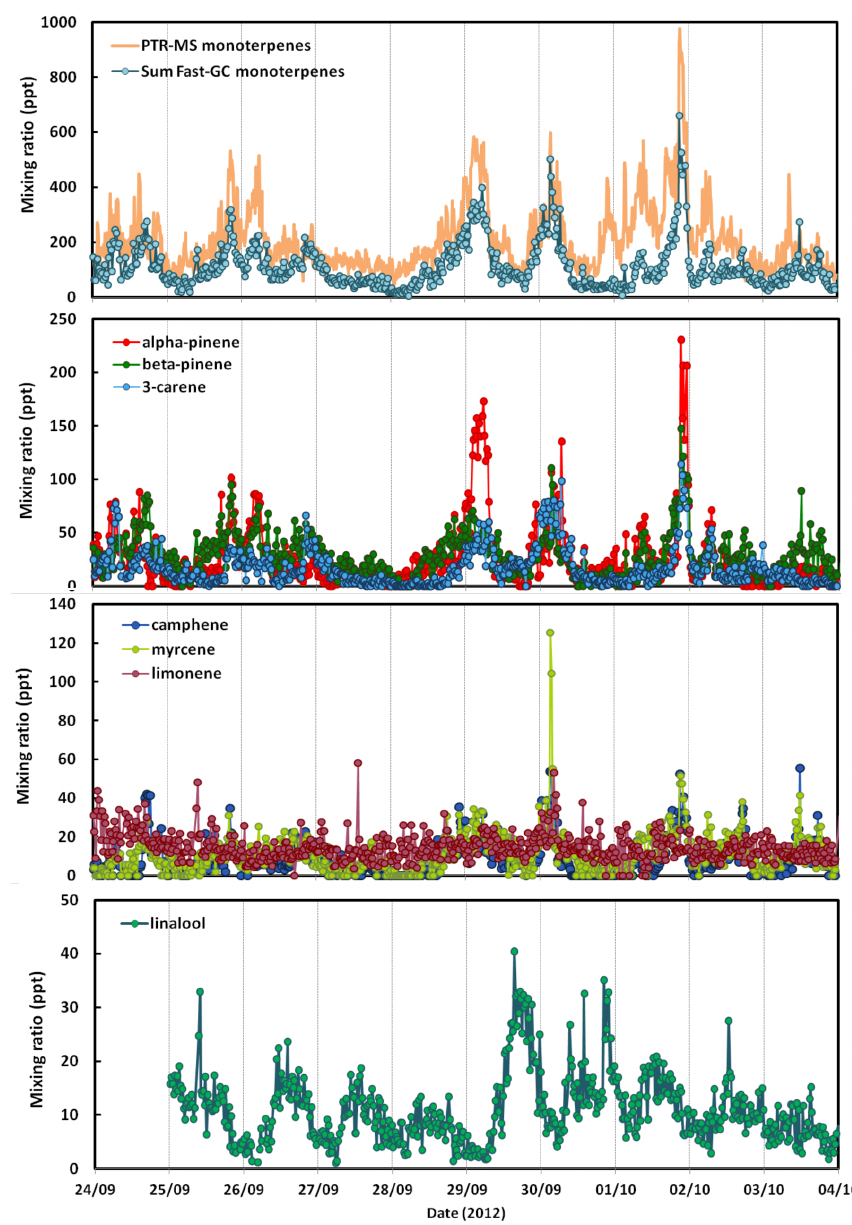
Fig. 6. Time series showing the sum of Fast-GC quantified monoterpenes and 10min averaged PTR-MS monoterpene signal, as well as mixing ratios of selected individual terpenes monitored by Fast-GC at the FM Tama field station in the Tokyo metropolis, during September– October 2012. Fast-GC analyses were performed using GC_AMBIENT II method, resulting in a sample frequency of 1 measurement every ∼ 22min. The Fast-GC instrumental uncertainties were 8–12% for monoterpenes, and 20% for